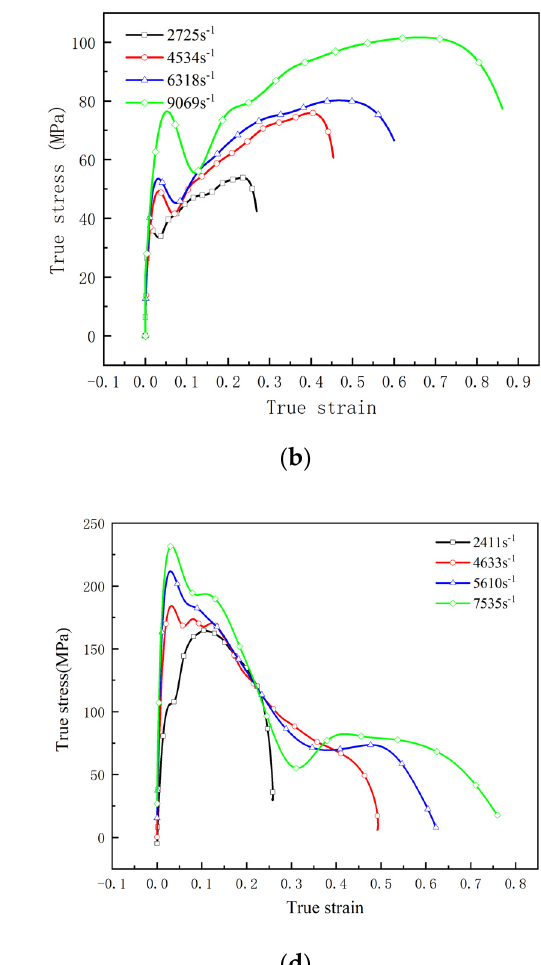
Figure 6. Quasi-static compressive performance curves of RMs: ( a ) 26.5% Al/73.5% PTFE ( b ) 5.29% Al/80% W/14.71% PTFE ( c ) 62% Hf/38% THV ( d ) 88% Hf/12% THV.